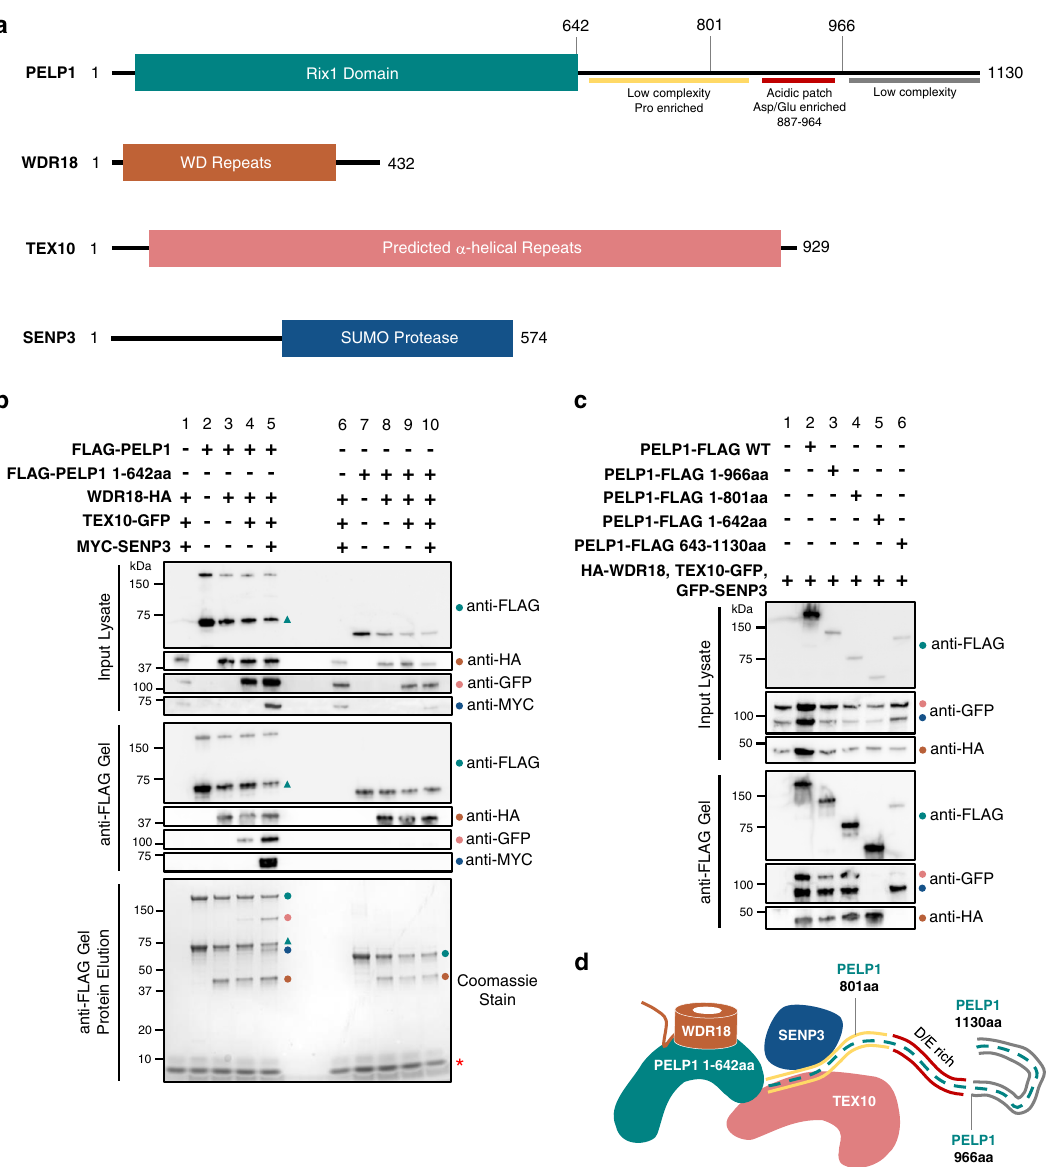
Fig.1|ReconstitutionofthehumanRix1complex.a Schematicrepresentationof human Rix1 complex members PELP1 (teal), WDR18 (orange), TEX10 (pink), and SENP3 (blue) with amino acid boundaries. b Western blot and total protein stain fromSDS-PAGEofsequentiallybuiltreconstitutedRix1complexesisolatedbyco-IP of N-terminal FLAG tagged PELP1 constructs. Lanes 1-5 are Rix1 complexes built overfull-lengthPELP1(1-1130aa)andlanes6-10arecomplexesbuiltoverPELP1Rix1 domain (1-642aa). Teal triangle denotes band representing C-terminal truncated PELP1 originating from full-length. Colored circles denote bands representing like-